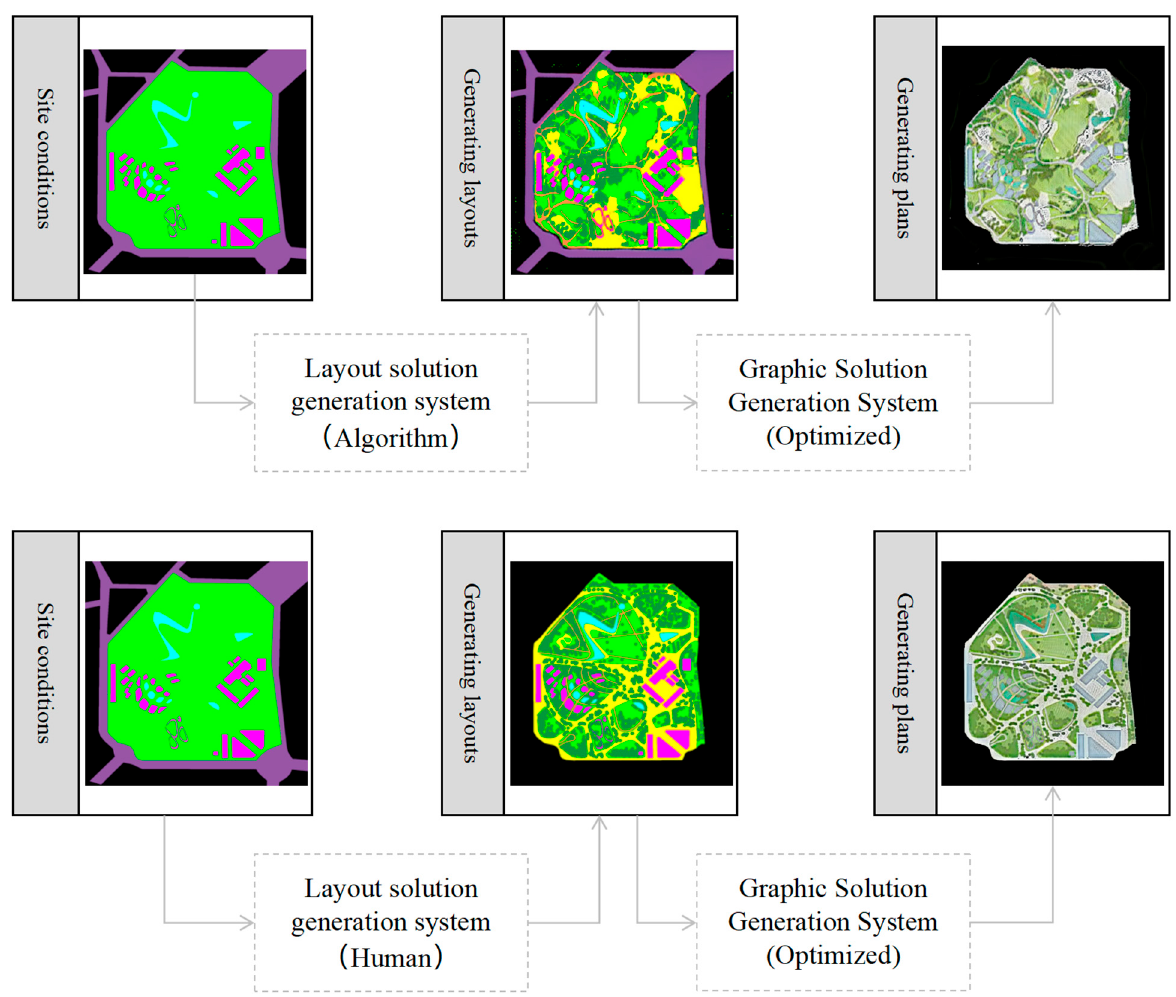
Figure 10. The work fl ow of design mode evaluation.